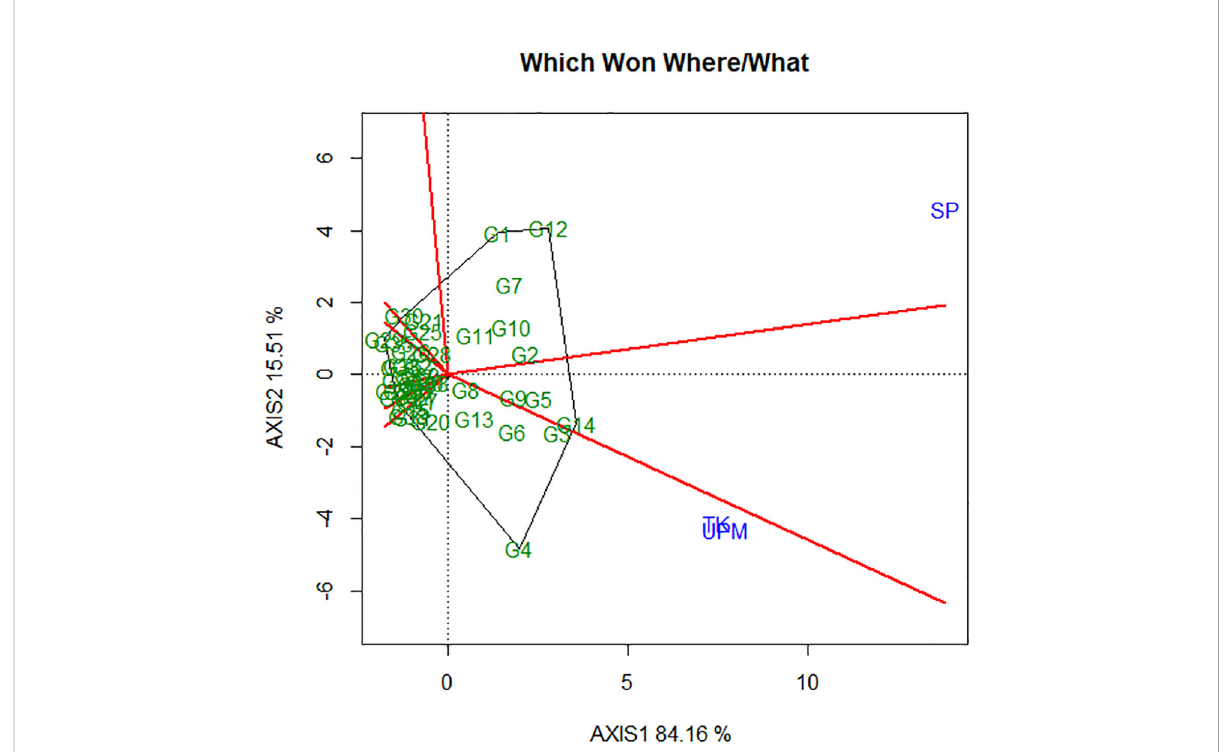
FIGURE 7 Polygon view of GGE biplot (which-won-where) showing the genotype main effects plus genotypic × environment interaction effect biplot (G + G × E) interaction effect of 41 rice genotypes in three locations for yield per